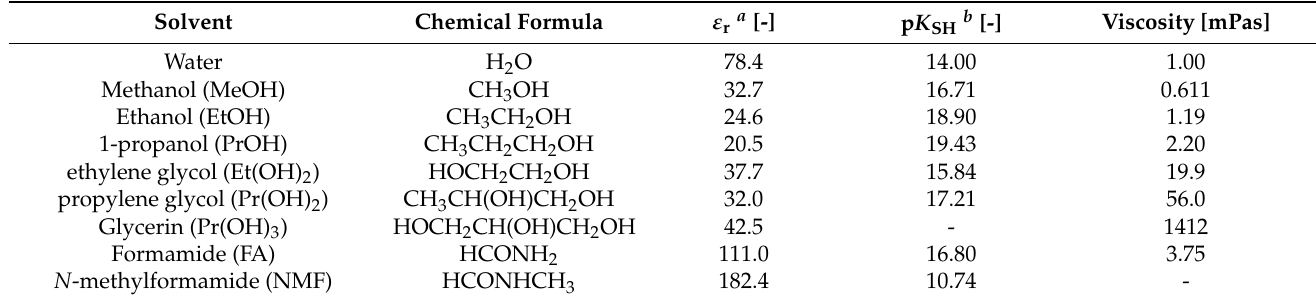
Table 1. Physicochemical properties of the solvents [12,13].